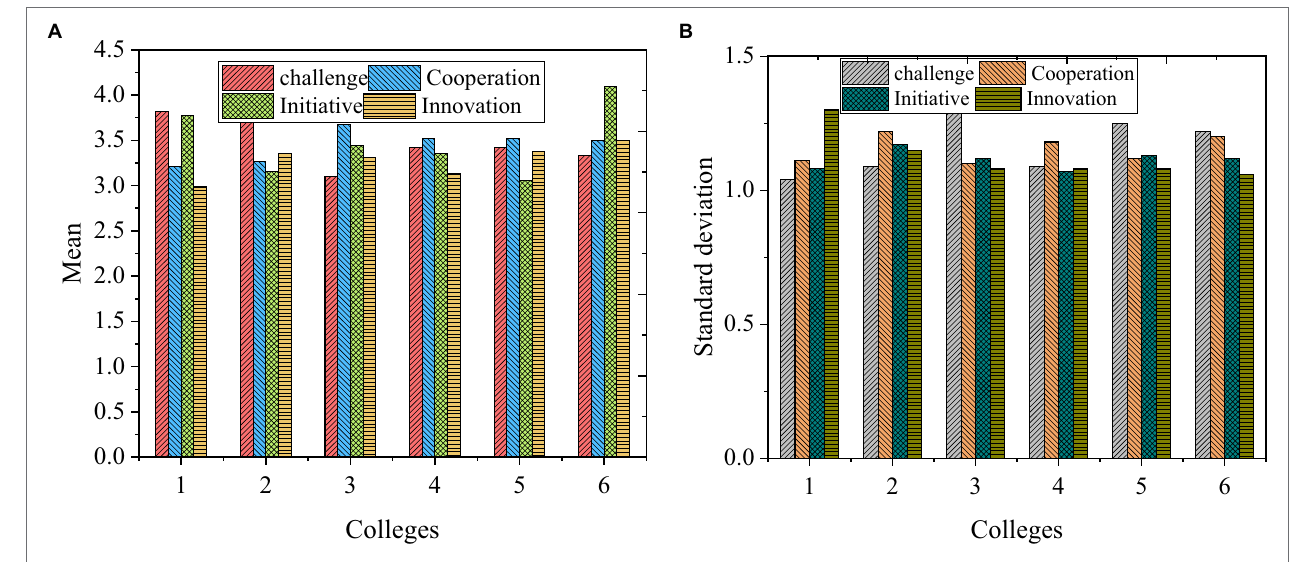
FIGURE 2 | Description of personality. (A) Mean, and (B) Standard